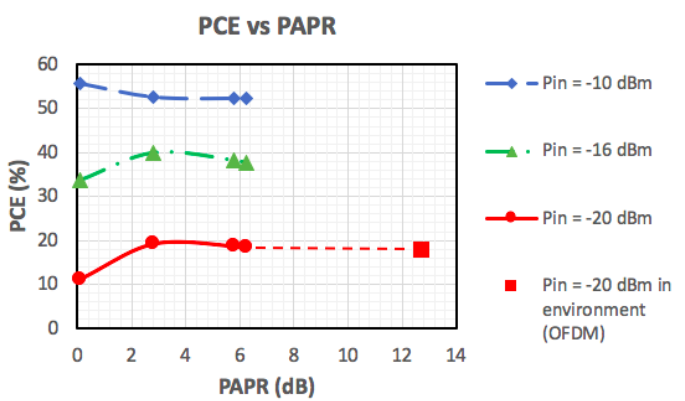
Figure 17. Measured PCE of the RFEH system in different loads in the anechoic chamber: ( a ) at − 20 dBm input power, and ( b ) at − 10 dBm input power.